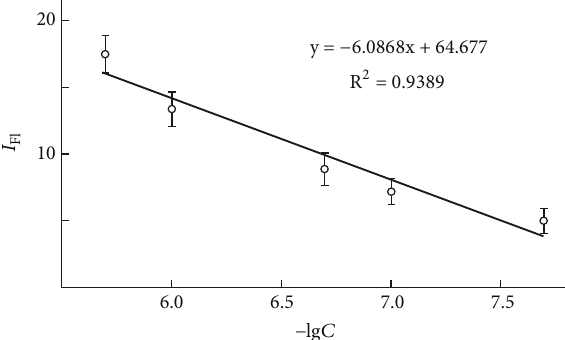
Figure 4: Calibration graph of the dependence of the fluorescence intensity ( 𝐼 Fl ) of pyrene on CDA matrices on the logarithm of its concentration (2 ⋅ 10 −6 - 2 ⋅ 10 −8 g/L) in a water-DMSO solution. 𝐼 Fl is measured at 𝜆 em = 394 nm and 𝜆 ex = 320